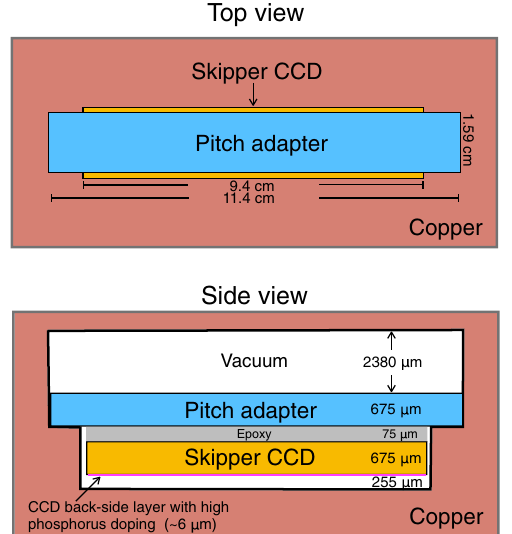
FIG. 14. Schematic depiction of the SENSEI Skipper CCD detector module in the MINOS cavern, a shallow underground site, for taking the data described in Ref. [68]. The active part of the detector is the Skipper CCD (orange). A Si pitch adapter (blue) is glued with epoxy (gray) to the Skipper CCD. This is placed inside a copper module (red). The CCD back side contains a few-micron-thick layer that is heavily doped with phosphorus (magenta). We omit several details of the detector, including a series of layers with thicknesses of the order of approximately 1 μ m or below that exist in between the Skipper CCD and the epoxy. The entire copper module shown is surrounded by lead bricks, placed inside a copper vessel, and then surrounded with additional lead shielding.